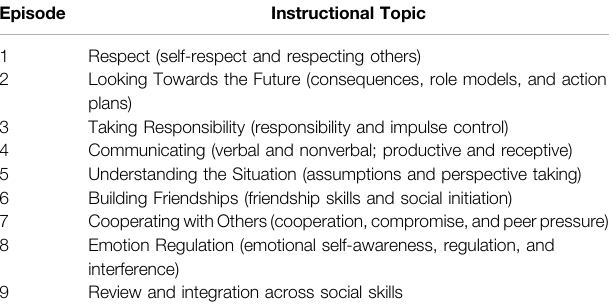
Table 1 | Episode Topics Episode